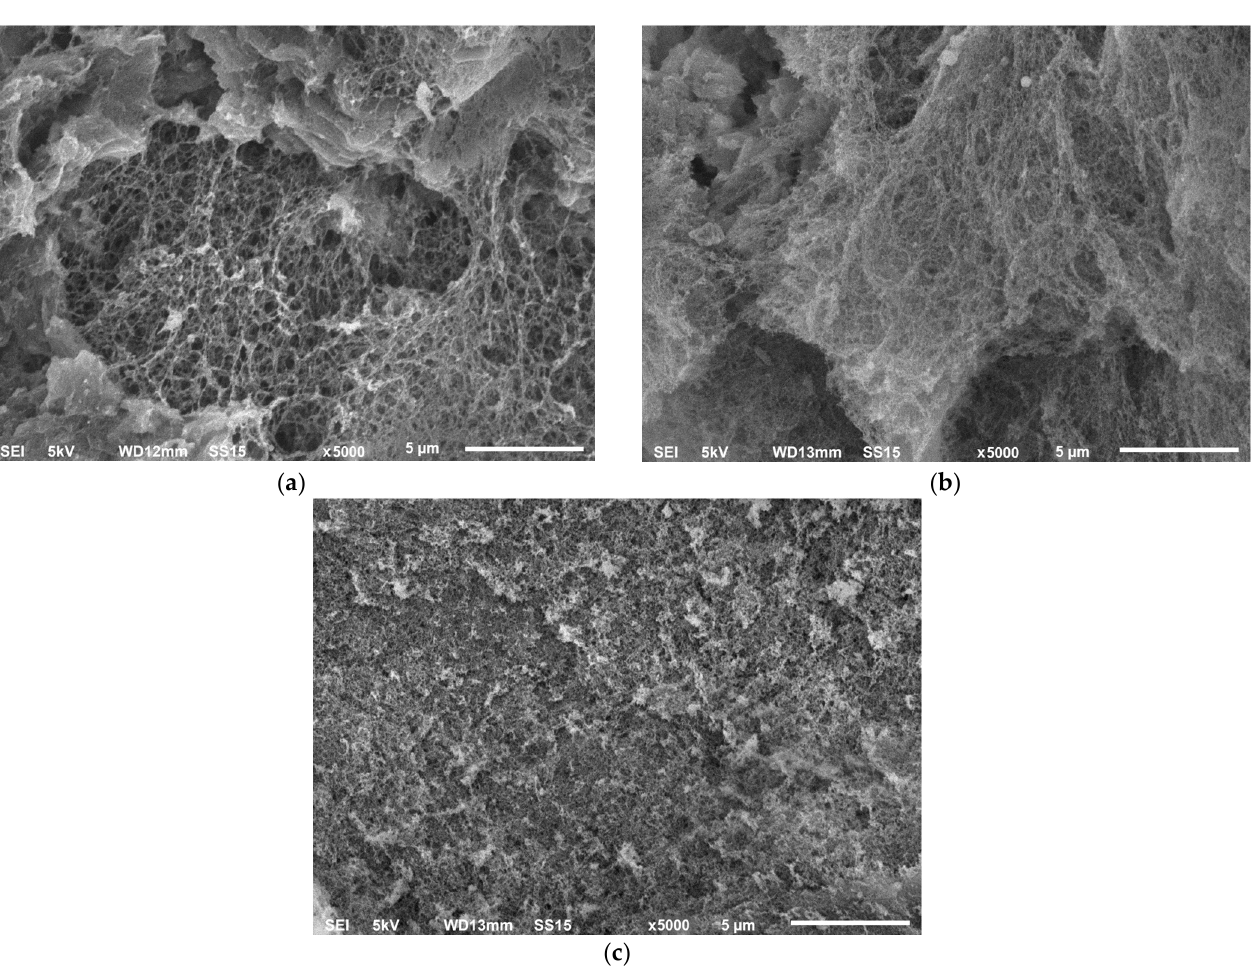
Figure 7. SEM image of the alginate aerogel with complex geometry after the crosslinking bath at concentrations of ( a ) 1 wt%, ( b ) 3 wt%, and ( c ) 5 wt%.